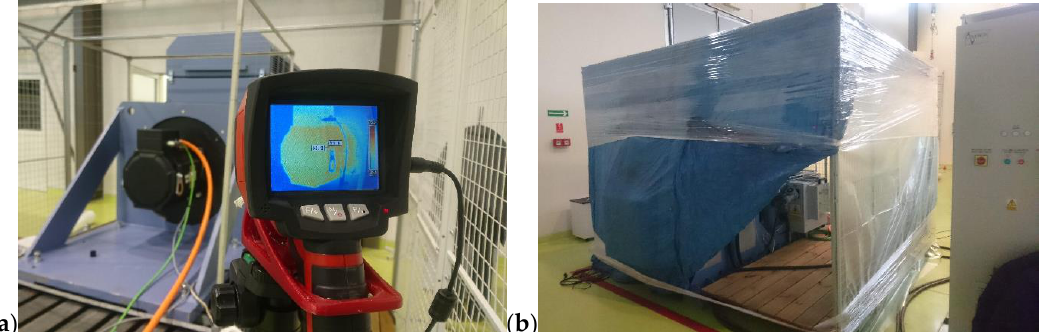
Figure 14. Registration of the motor housing temperature during the test ( a ) and a view of the dynamometer stand adapted to obtain an elevated ambient temperature ( b ).